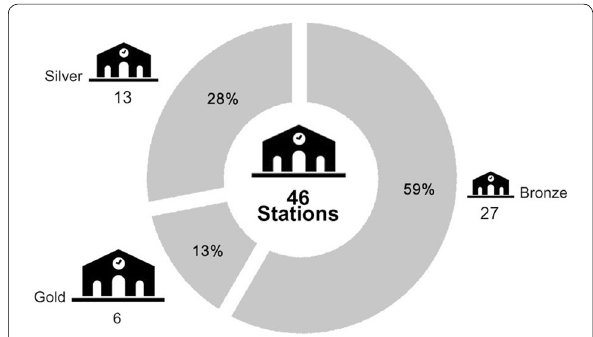
Fig. 4 Classification of stations in proximity with the VENTO path (part considered in the project)